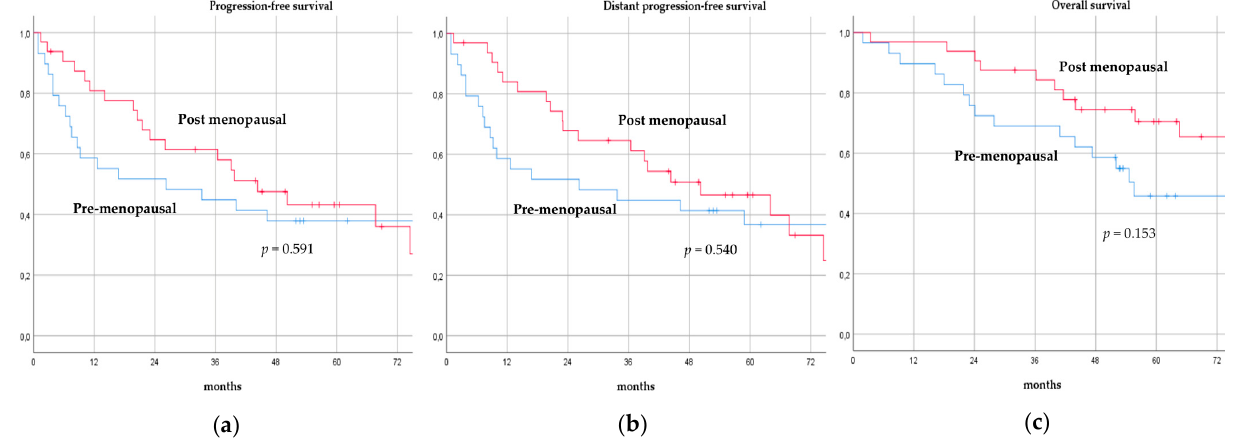
Figure 1. Progression-free survival ( a ), distant progression-free survival ( b ), and overall survival ( c ) curves of de novo metastatic breast cancer patients according to menopausal status.